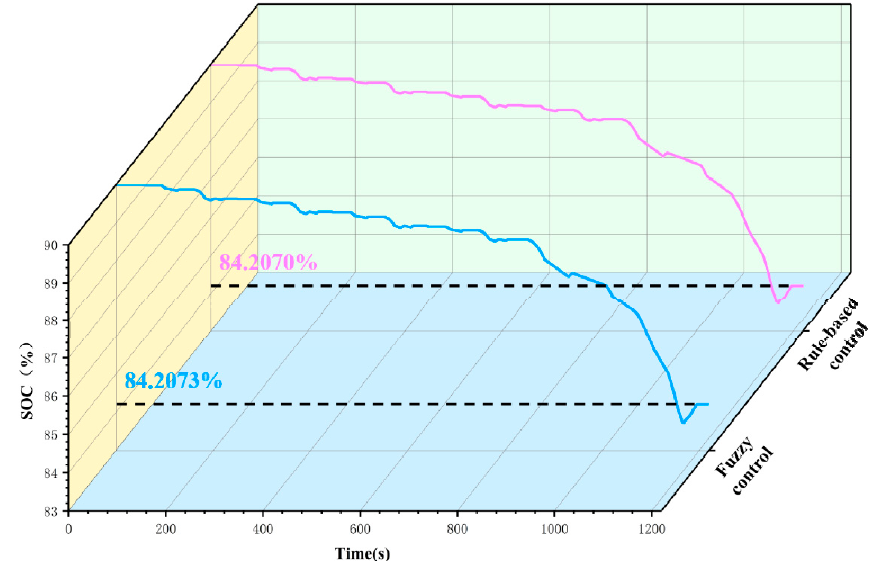
Figure 14. Fuzzy optimization analysis: battery SOC curve.